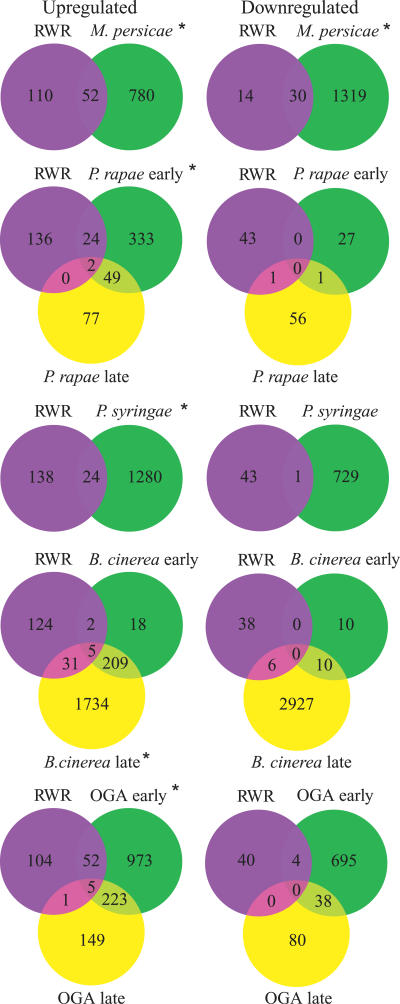
Comparison of RWR Genes with the Transcript Profile of Other Environmental StimuliAn asterisk denotes a statistically significant overrepresentation of RWR genes in the transcript profile of the indicated stress (p < 0.0001). Arabidopsis plants were challenged with M. persicae for 48 h and 72 h; P. rapae early for 5 h; P. rapae late and P. syringae for 12 h and 24 h; B cinerea early and late for 18 h and 48 h, respectively; and OGA early and late for 1 h and 3 h, respectively [59–61].